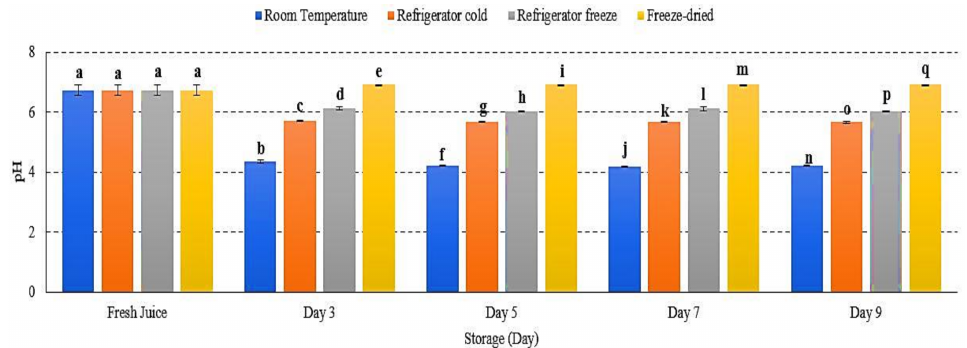
Figure 2. The pH values of watermelon juice during 9 days of storage at different storage temperatures. Different letters indicate significant differences between samples p <